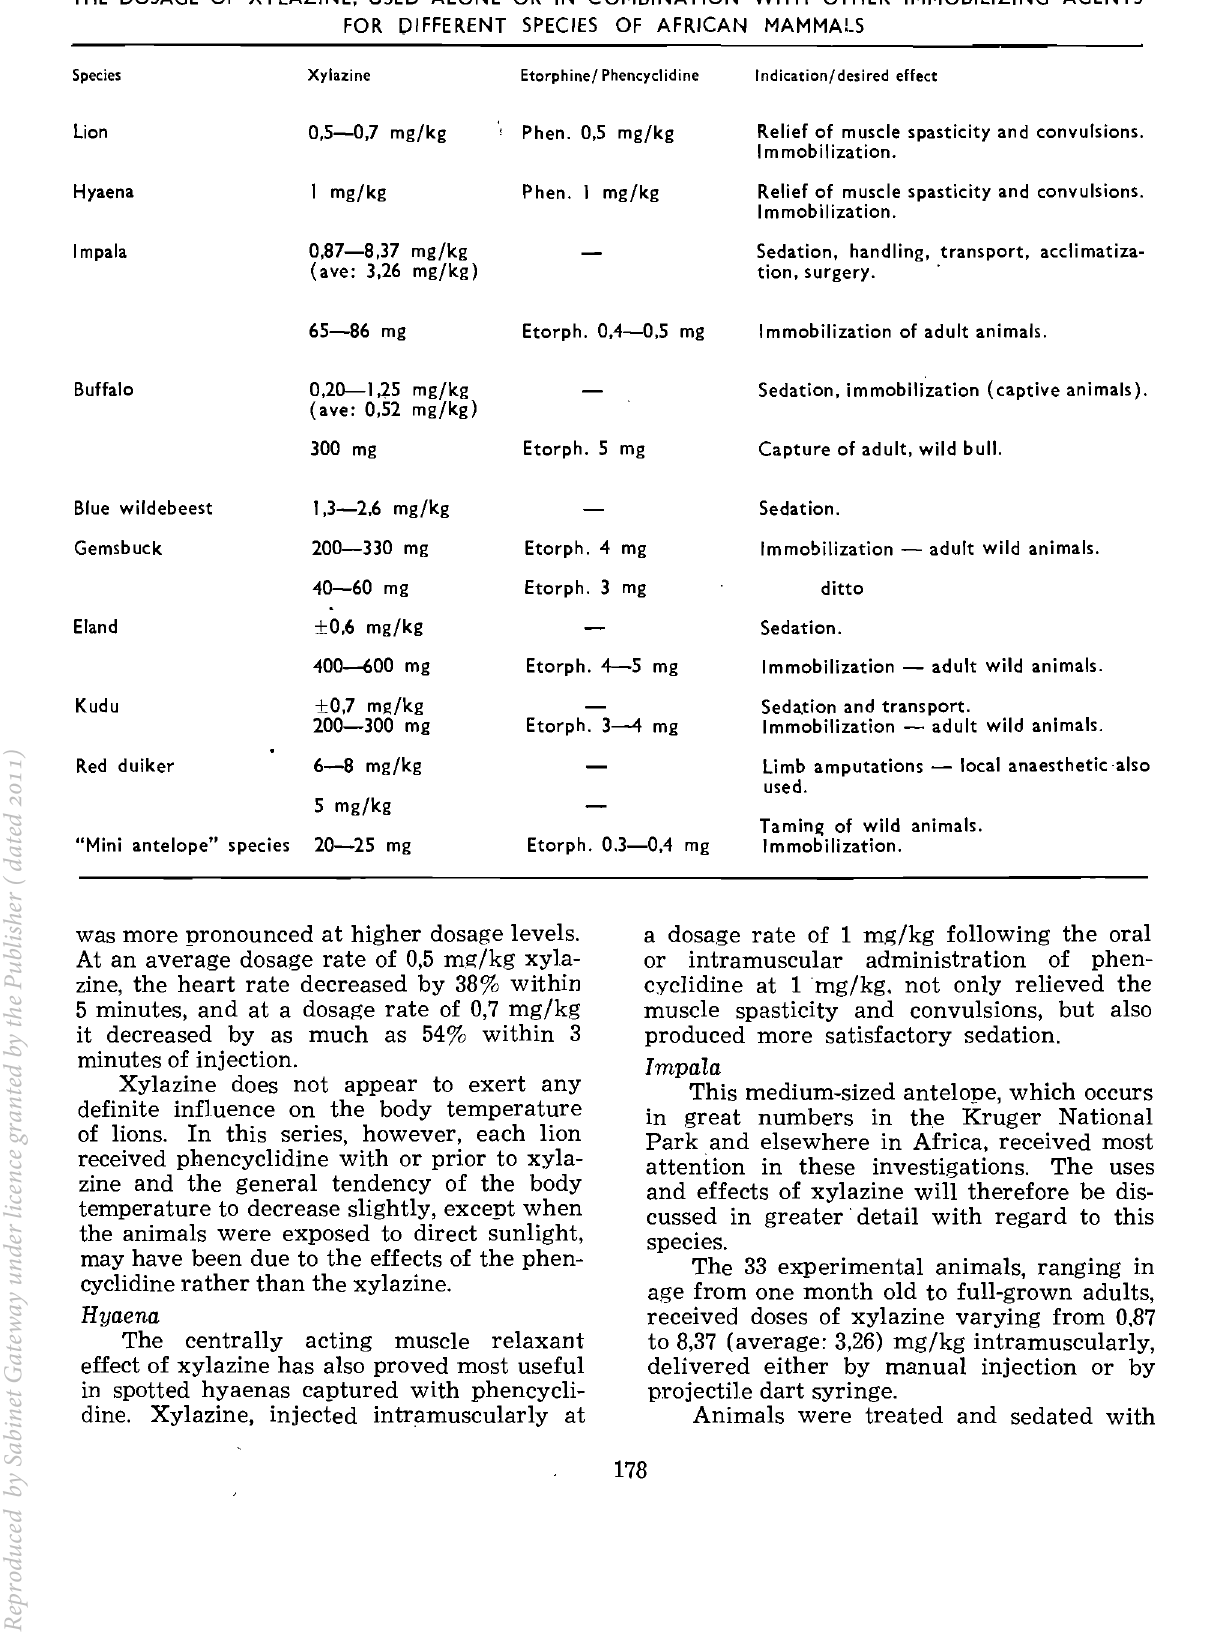
Taming of wild animals.